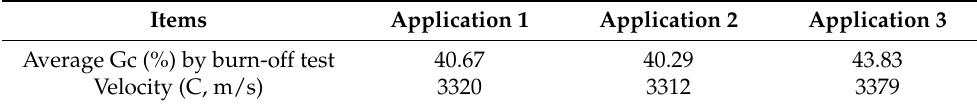
Table 5. Ultrasonic pulse-echo velocity implemented for hull plate prototypes.